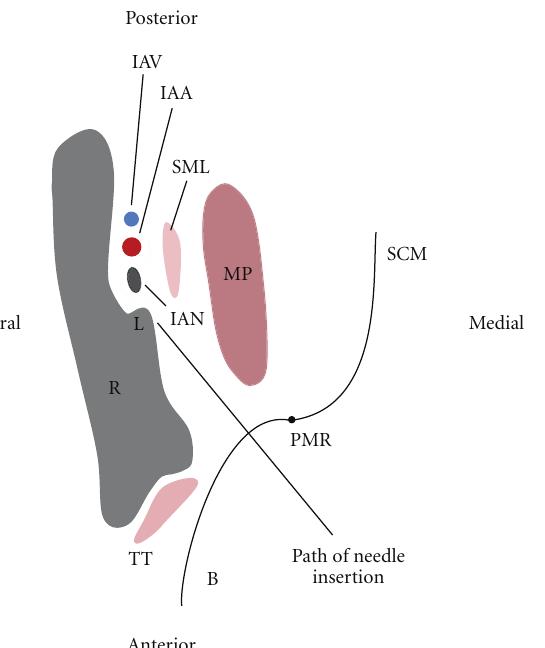
Figure 1: Transverse section of the mandibular ramus at the level just superior to the lingula. (R: Ramus, IAN: inferior alveolar nerve, IAV: inferior alveolar vein, IAA: inferior alveolar artery, SML: sphenomandibular ligament, MP: medial pterygoid muscle, B: buccinator, PMR: pterygomandibular raphe, SCM: superior constrictor muscle, TT: tendon of temporalis L: lingula). The needle is shown passing through the pterygomandibular space where it is directed to an area of bone just superior to the lingula, L. This is the level at which an IANB should be